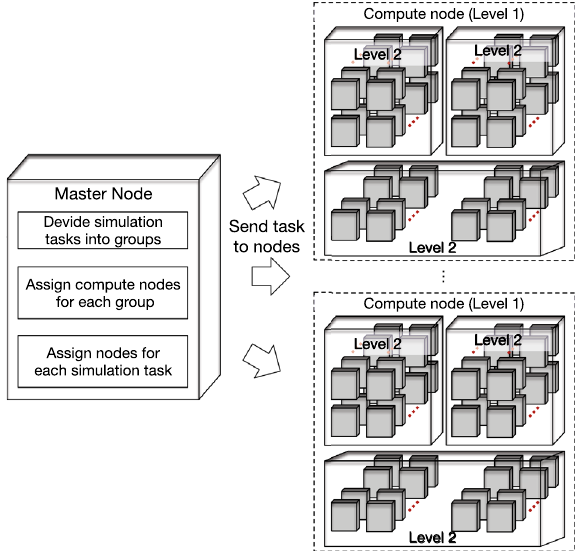
Figure 5. Illustration of multiple simulation tasks scheduling on the super computer.